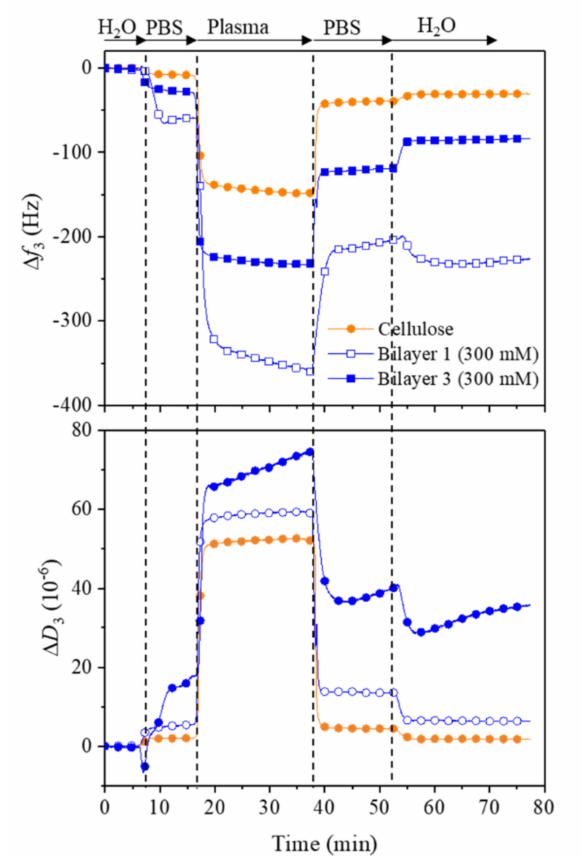
Figure 9. QCM-D change in frequency ( A ) and dissipation ( B ) for the adsorption plasma on bilayer 1 and 3 built on cellulose